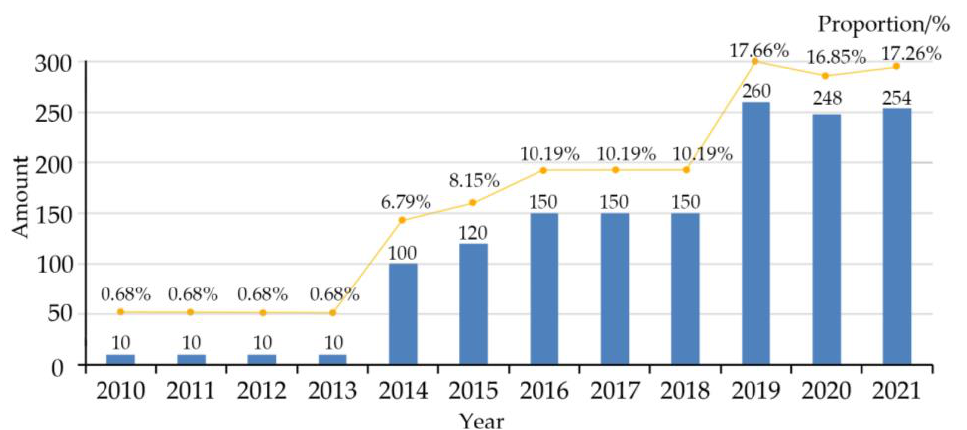
Figure 1. The development process of the list of beautiful leisure villages in China.